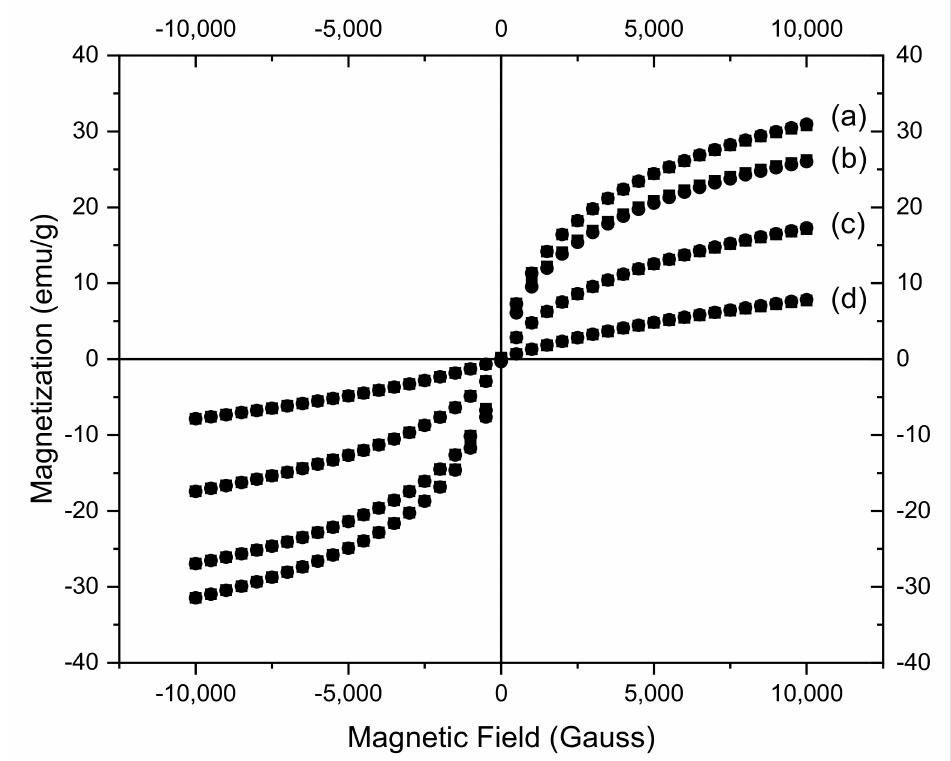
Figure 11. Magnetization curves of (a) CoFe 2 O 4 − 0; (b) CoFe 2 O 4 − 0.1; (c) CoFe 2 O 4 − 0.25; (d) CoFe 2 O 4 − 0.5 at room